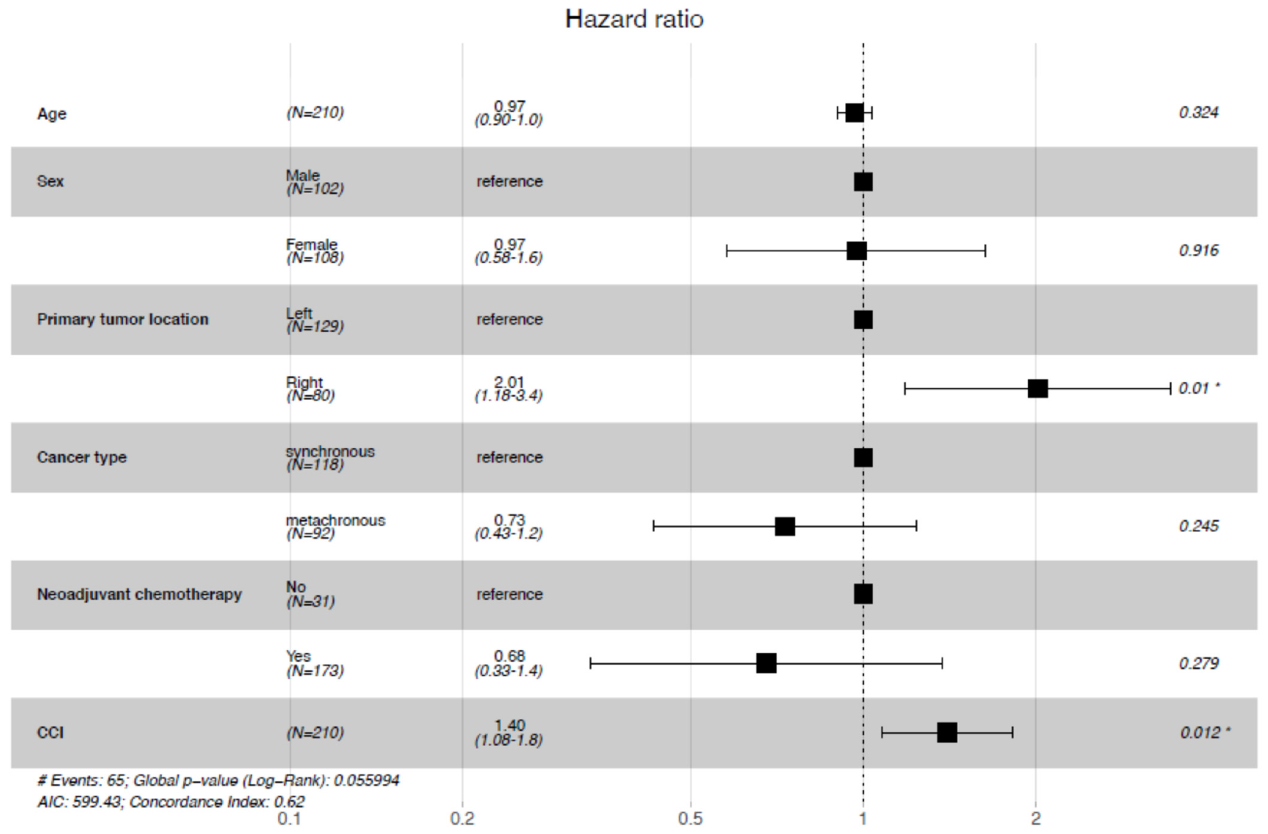
Figure 5. Multivariate analysis for overall survival. CCI: Charlson Comorbidity Index, *: significant p -value.